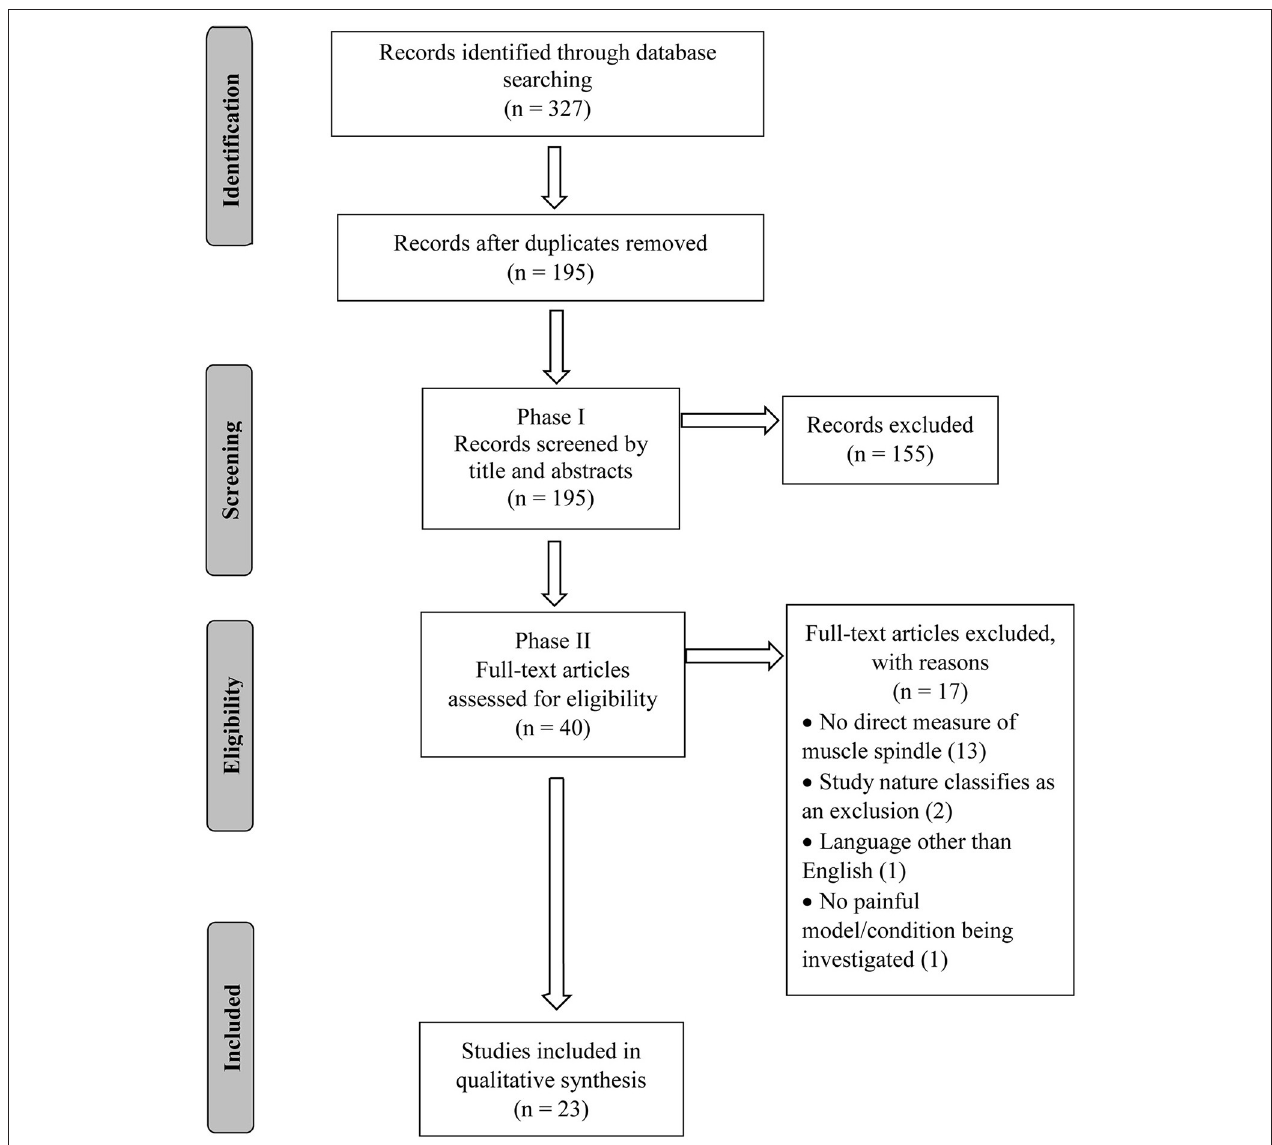
FIGURE 1 | Flowchart